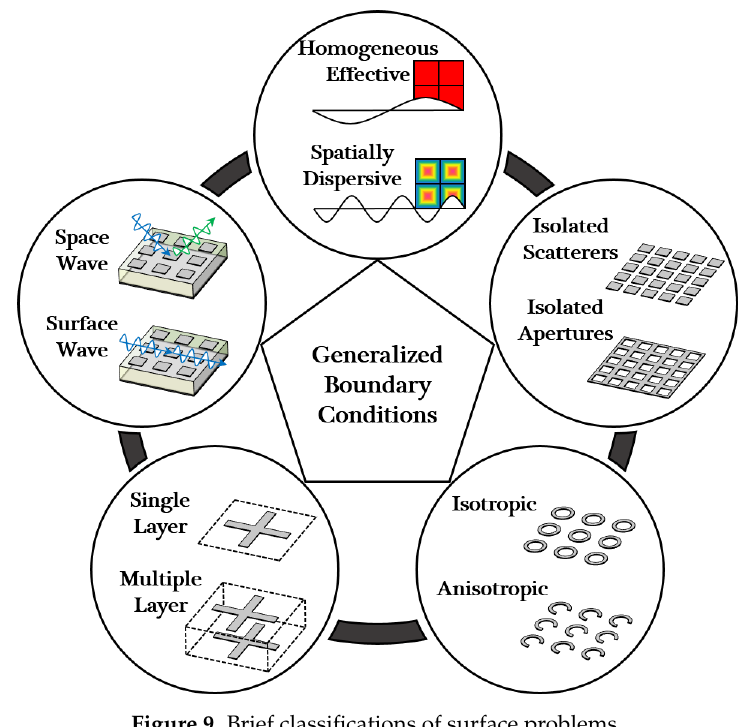
Figure 9. Brief classifications of surface